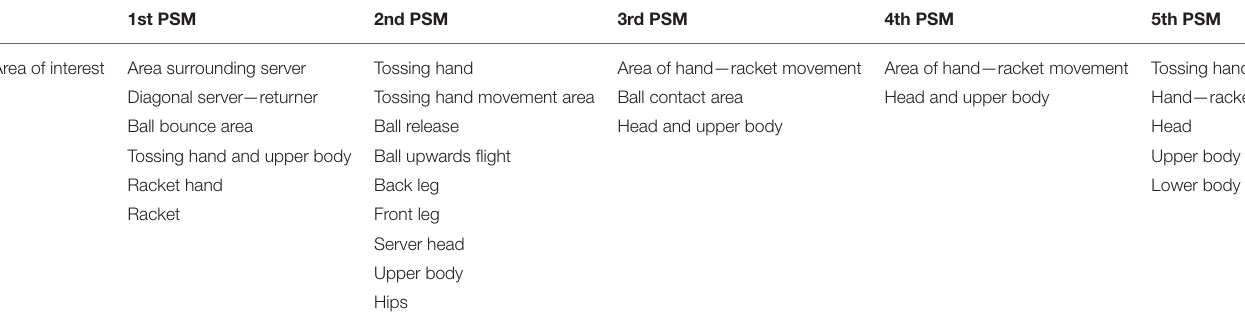
TABLE 1 | Definition of areas of interest in specific phases of the movement of